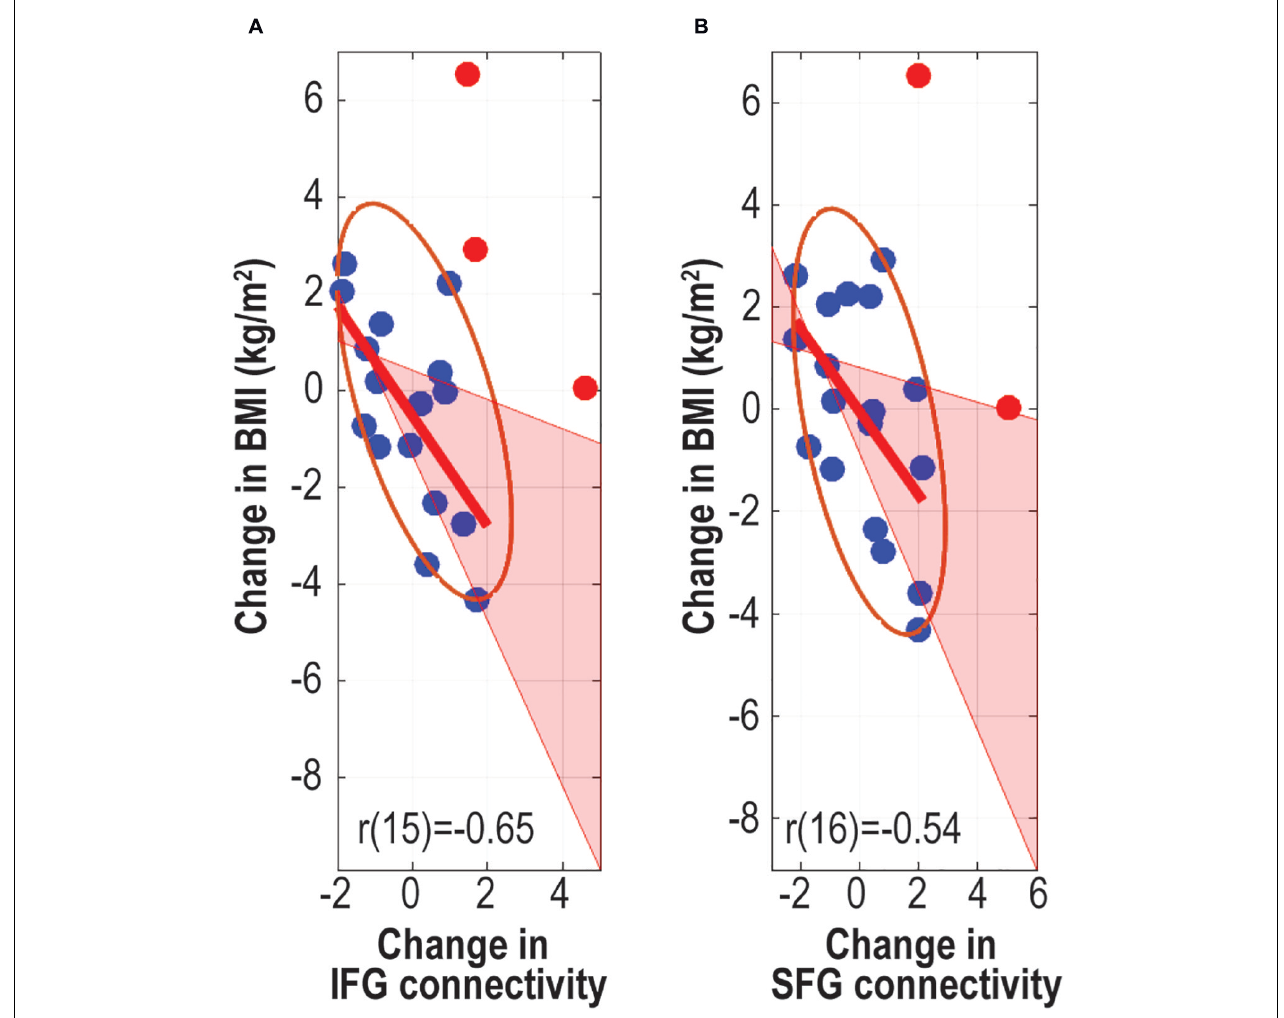
FIGURE 4 | Associations between change in body mass index and change in caudate-related connectivity. Scatter plots depict associations between change in body mass index and caudate-related functional connectivity in the inferior frontal gyrus (A) and superior frontal gyrus (B) . r values are skipped Pearson’s correlational coefficients. Red data-points indicate outliers. IFG, inferior frontal gyrus; SFG, superior frontal